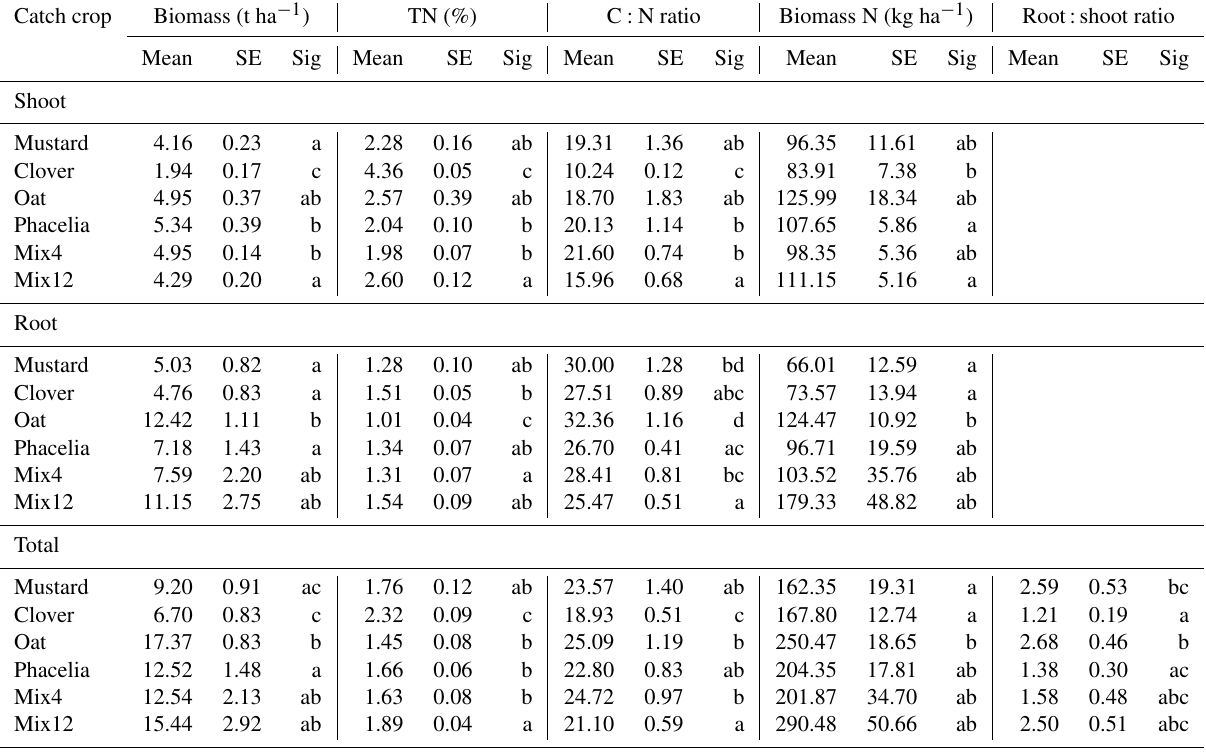
Table 1. Plant biomass data of shoots, roots and total biomass from different CC treatments. Mean values of six plots per treatment and standard error (SE) are shown. Small letters (Sig) represent contributions to significantly different groups at p< 0 . 05. Catch